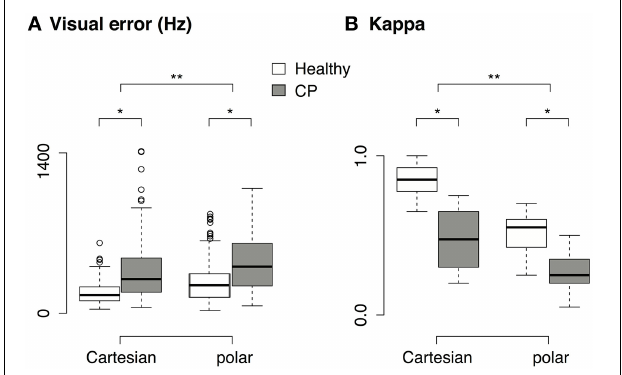
FIGURE 8 | (A) Visual error across population and transform. Only data from the brachioradialis muscle are shown, since the patients with CP were only tested with this muscle. (B) Cohen’s κ across population and transform. Only data from brachioradialis muscle are shown. ∗ p < 0 . 05, ∗∗ p < 0 . 001.